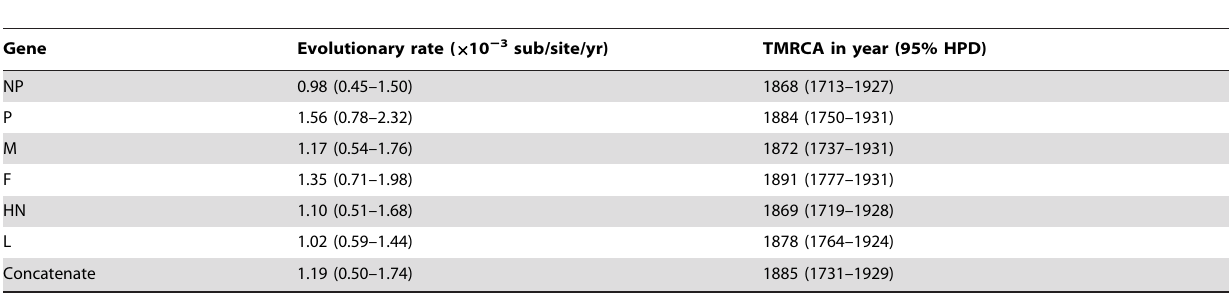
Table 1. Bayesian estimates of evolutionary rates (nucleotide substitutions per site per year) and TMRCAs (in year) for different genes of class II